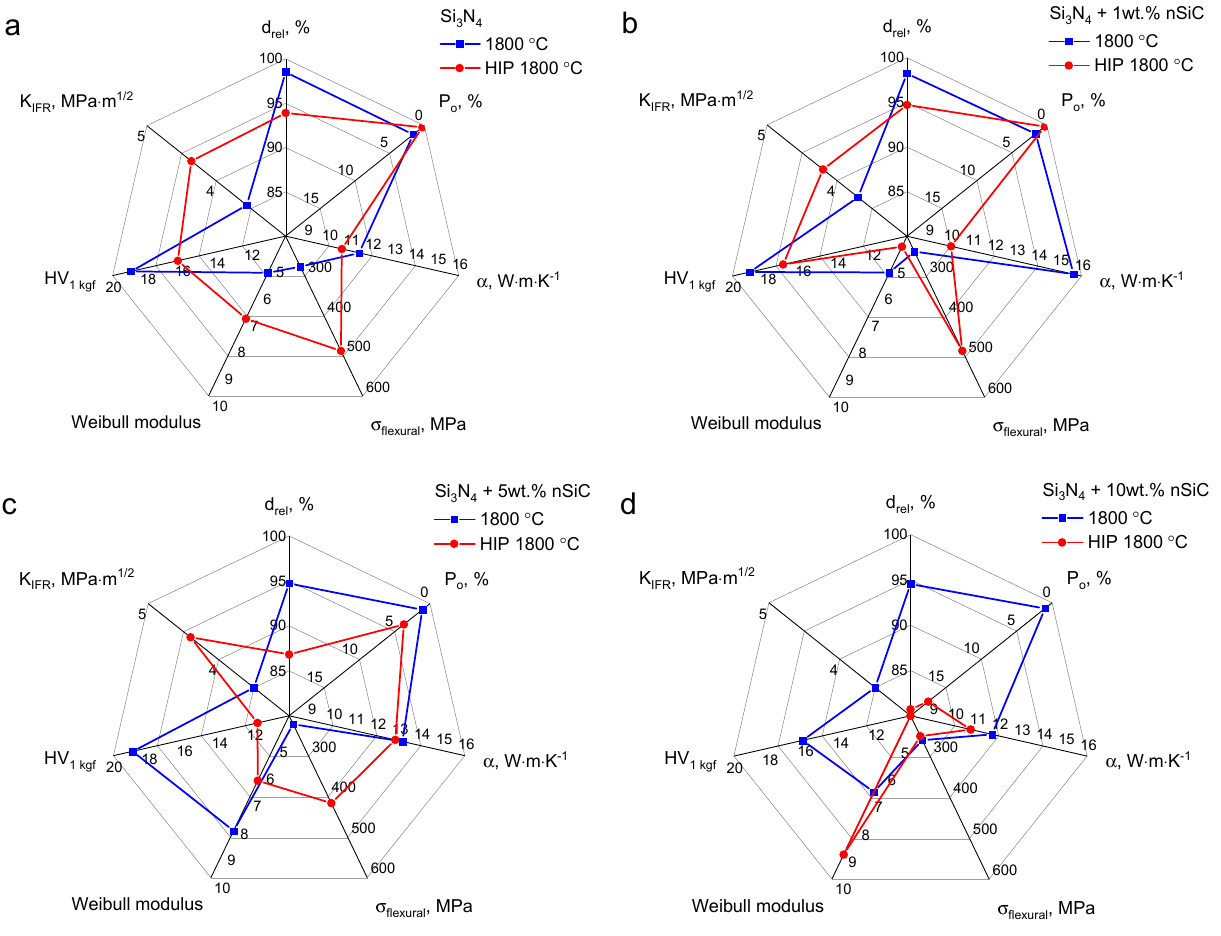
Figure 7. Radial graphs of the selected physical, thermal, and mechanical properties of the Si 3 N 4 ceramics ( a ), Si 3 N 4 -1 wt.% nSiC ( b ), Si 3 N 4 -5 wt.% nSiC ( c ) and Si 3 N 4 -10 wt.% nSiC ( d ) materials obtained by pressureless sintering (1800 °C) and under conditions of high temperature and high isostatic pressure (HIP 1800 °C). The materials sintered in the pressureless regime all had some level of open porosity.